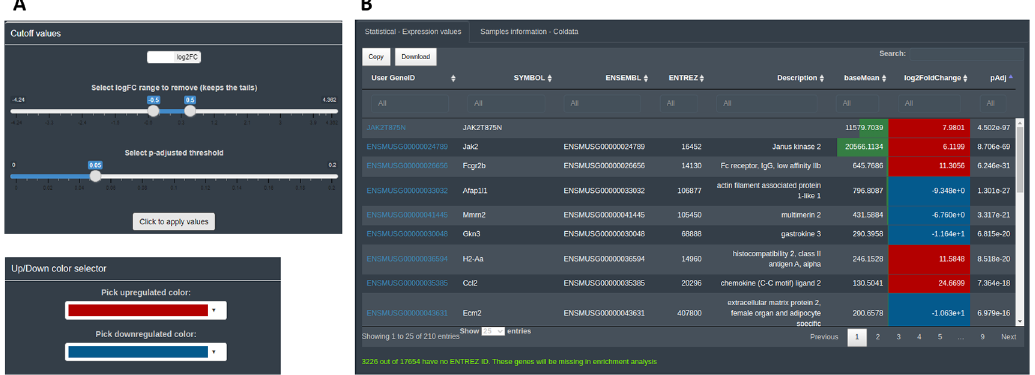
Figure5.BasicdatavisualizationforDEGsinDEVEA. A:Controlsusedtosetthestatisticalthresholdsandgraphical features parameters. B: Interactive result table.